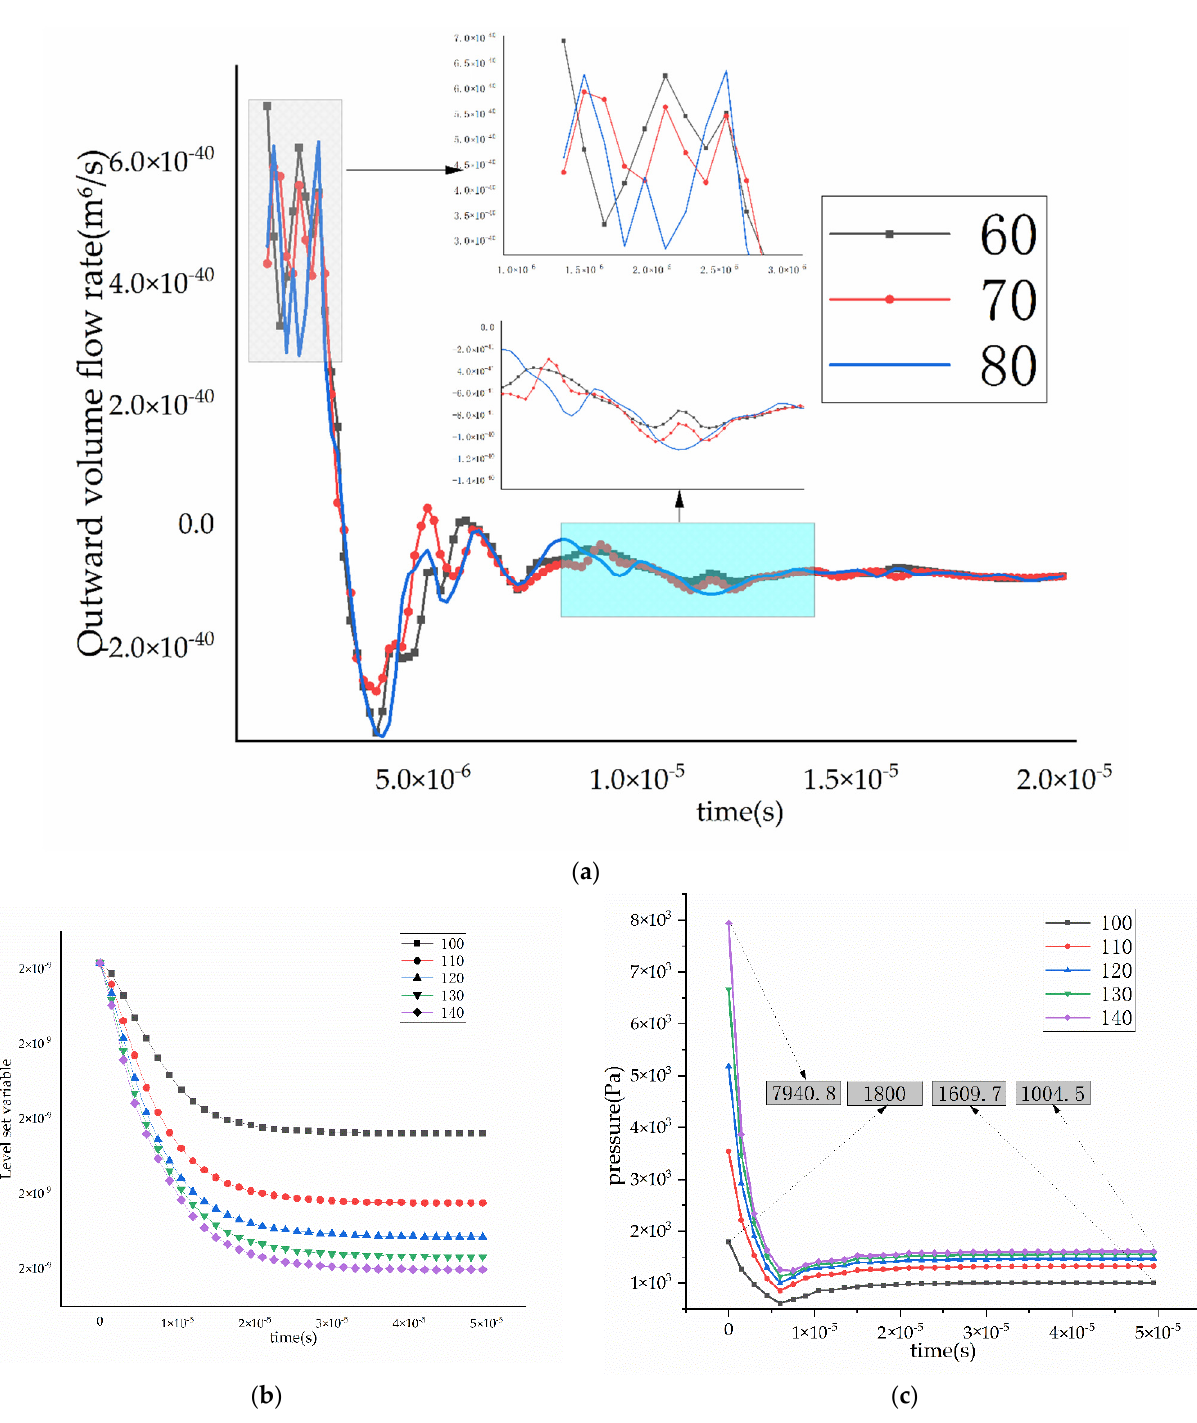
Figure 7. The motion state of the liquid with the same pore diameter on different wettability walls. ( a ) is the flow rate of liquid outflow domain 2 when hydrophilic, and ( b ) is the variable integral at the boundary of domain 2 when hydrophobic. ( c ) is the pressure on the fluid interface when it is hydrophobic.